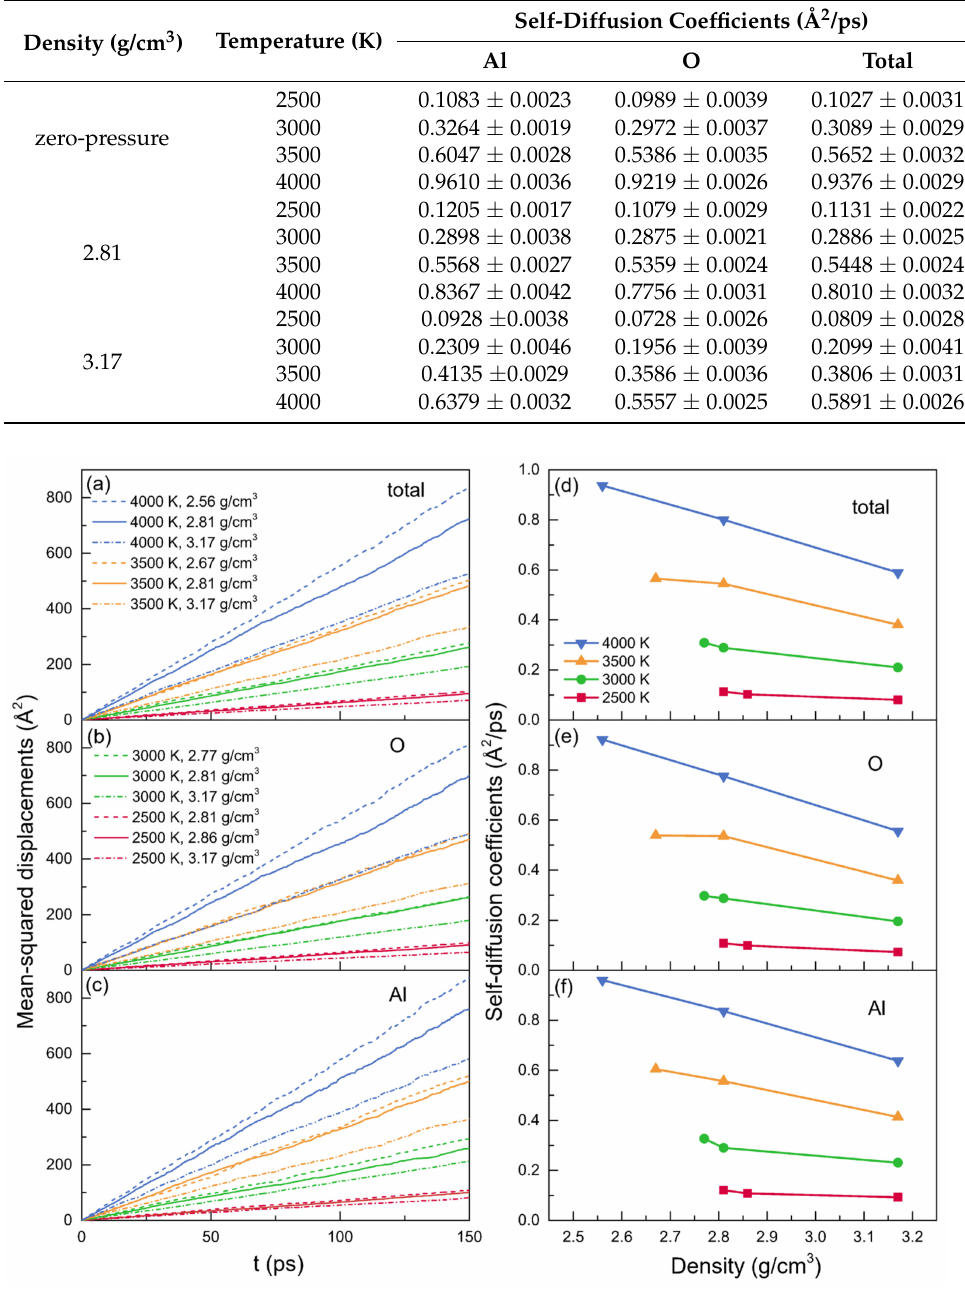
Table 4. Self-diffusion coefficients for liquid alumina at the temperature ranging from 2500 K to 4000 K.